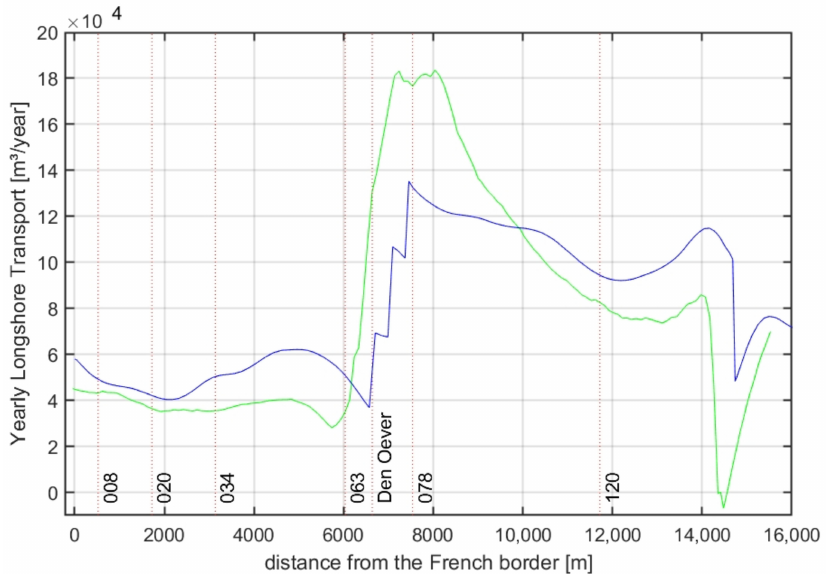
Figure 15. Comparison of the littoral drift between Scaldis Coast (in green) and Unibest (in blue). At a distance of 6300 m the Unibest result is ca. 56,000 m 3 /year, at a distance of 7800 m it is ca. 140,000 m 3